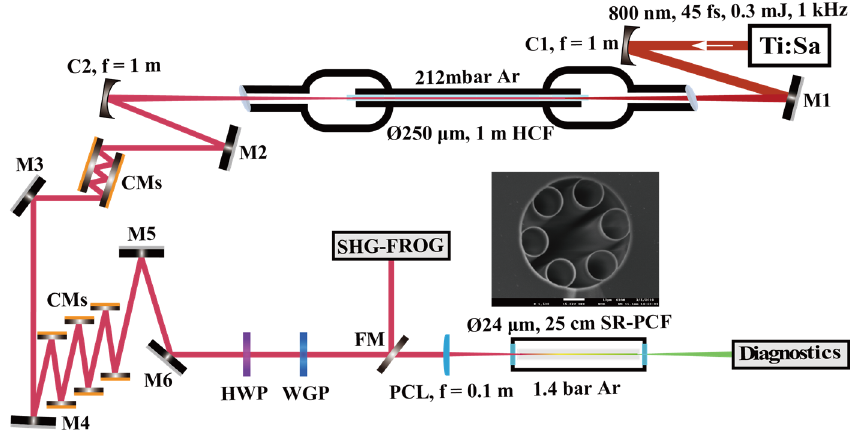
Figure 1. Schematic of the experimental set-up (Visio 2013, Microsoft, WA, USA). M1–M6, silver mirrors; C1-C2, concave mirrors; CMs, chirped mirrors; HWP, half-wave plate; WGP, wire grid polarizer; FM, flipping mirror; PCL, plano-convex lens. The inset in the set-up represents SEM of the SR-PCF with a core diameter of 24 µm and a wall thickness of ~0.26 µm.